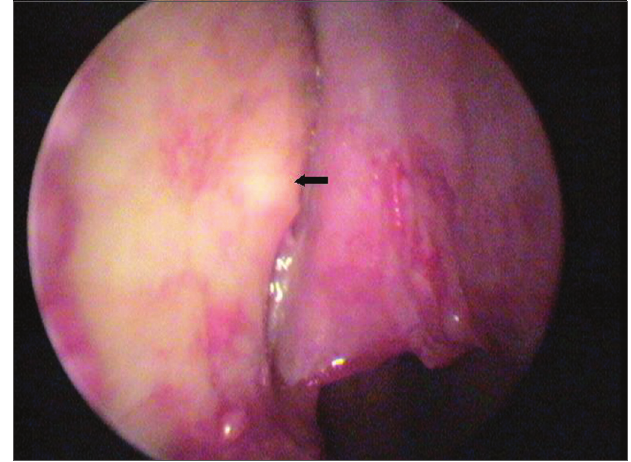
Figura 3. Ponto de transiluminacão (seta) na parede lateral óssea da cavidade